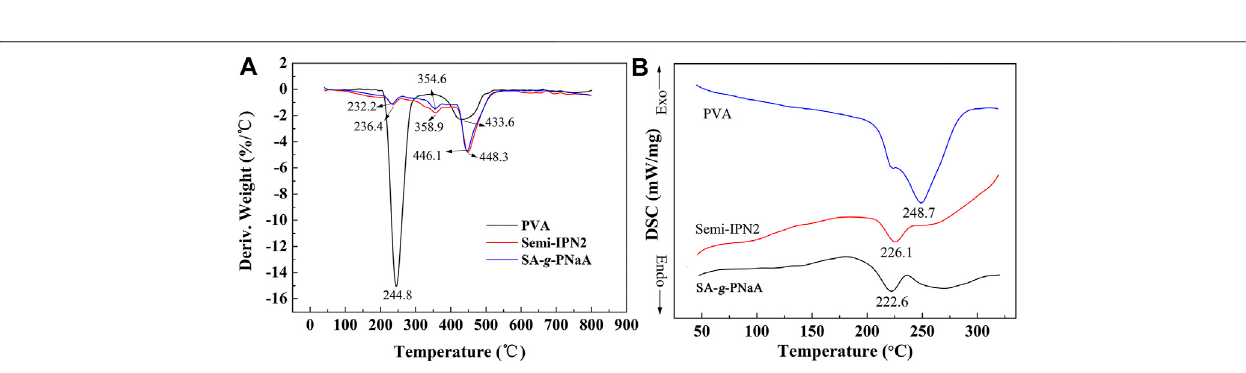
Frontiers in Chemistry |